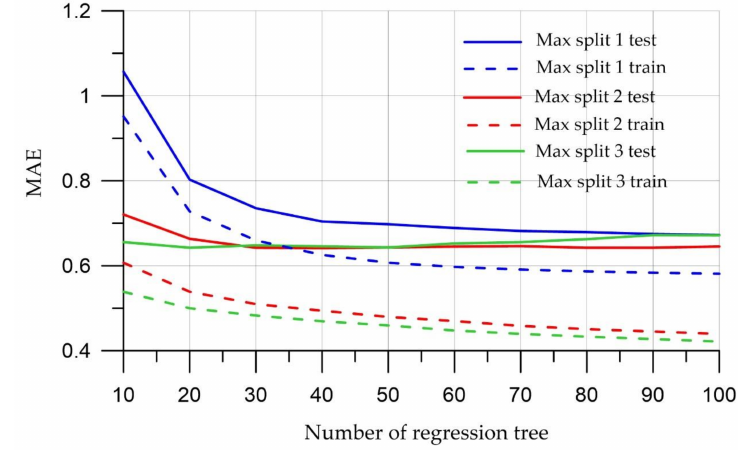
Figure 3. Mean Absolute Error meaning.